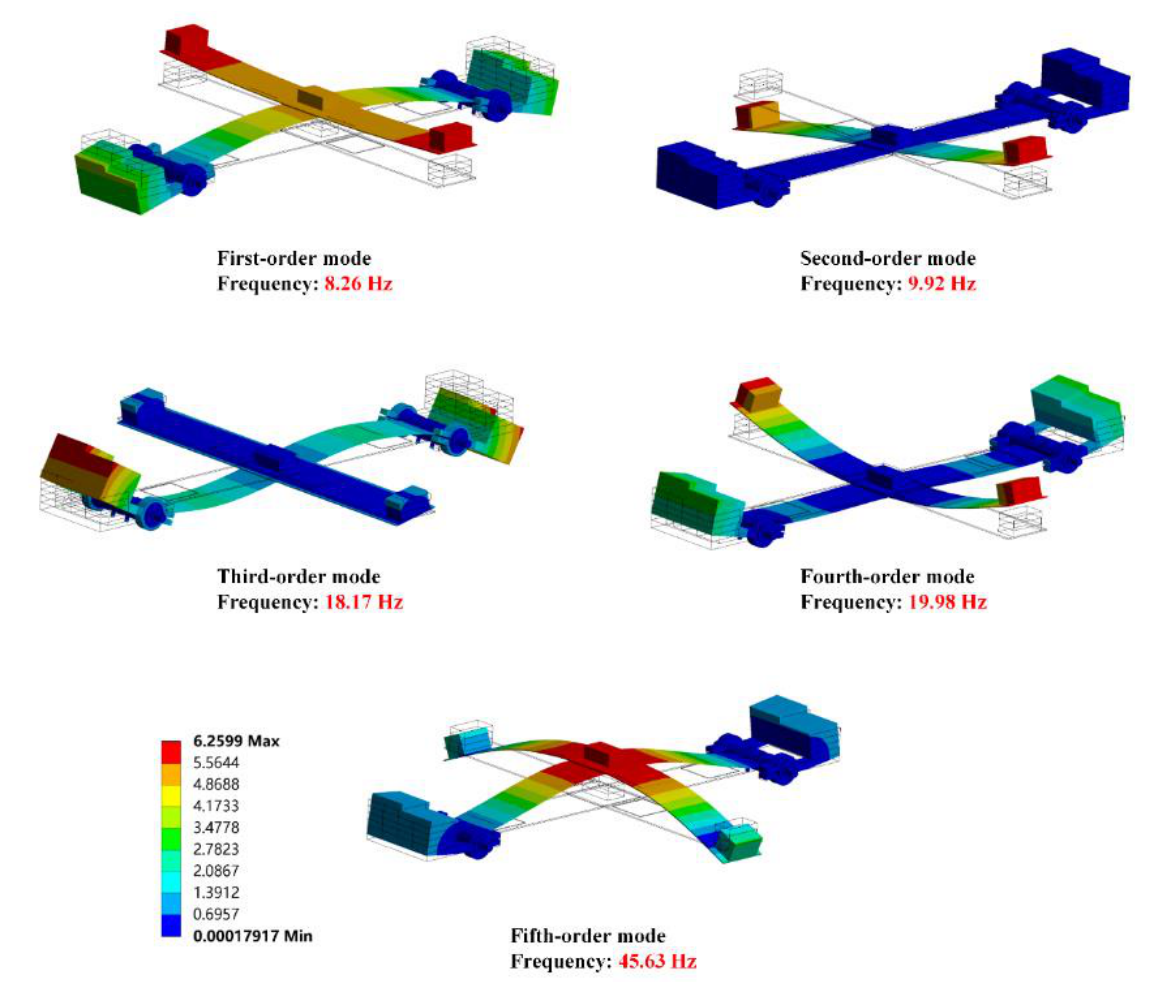
Figure 4. Modal analysis of the energy harvester.